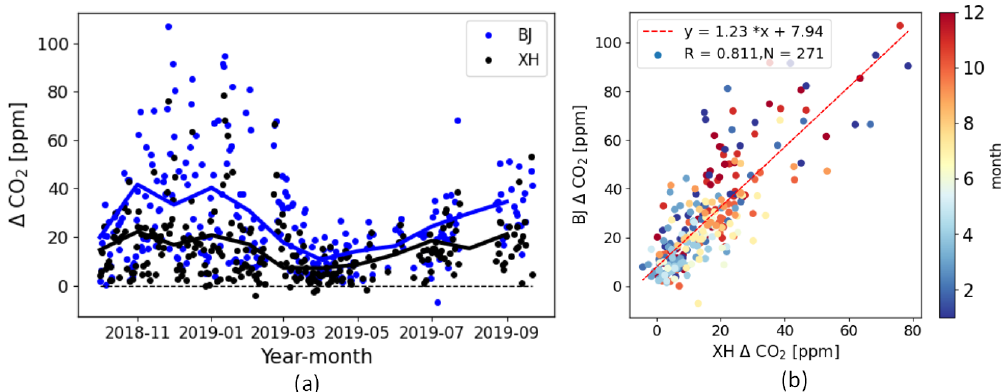
Figure 7. (a) The time series of daily CO 2 enhancements at BJ and XH relative to XL between October 2018 and September 2019. The blue and black lines are the monthly means of CO 2 enhancements at BJ and XH, respectively. (b) The correlation between daily mean CO 2 enhancements at BJ and XH.